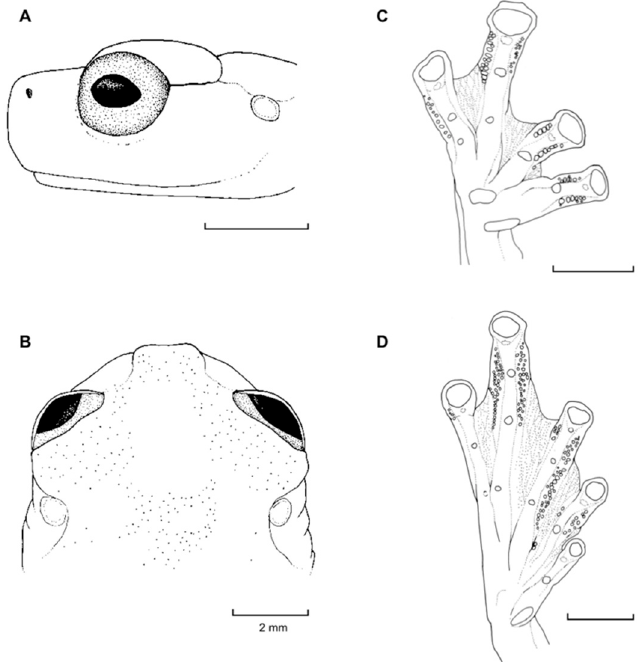
Figure 103. Hyalinobatrachium aureoguttatum , adult male, QCAZ 27429. ( A ) Head in lateral view. ( B ) Head in dorsal view. ( C ) Hand in ventral view. ( D ) Foot in ventral view. Illustrations by Juan M.